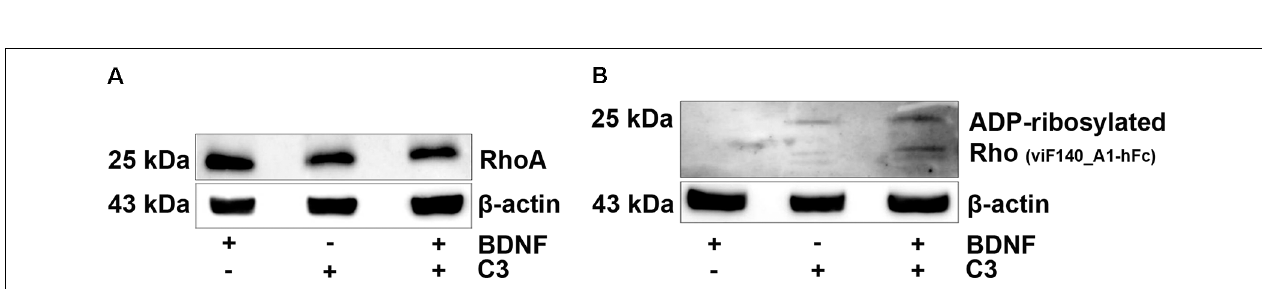
FIGURE 1 | Screening of different concentrations and constructs of C3. The number of neurons per well is after the treatment with the three constructs of C3 at nanomolar concentrations (1 nM, 20 nM, 50 nM, and 100 nM) for 48 h on a comparable level to the negative control. Thus, the treatment of spiral ganglion neurons (SGN) with different constructs and concentrations of C3 is not toxic.